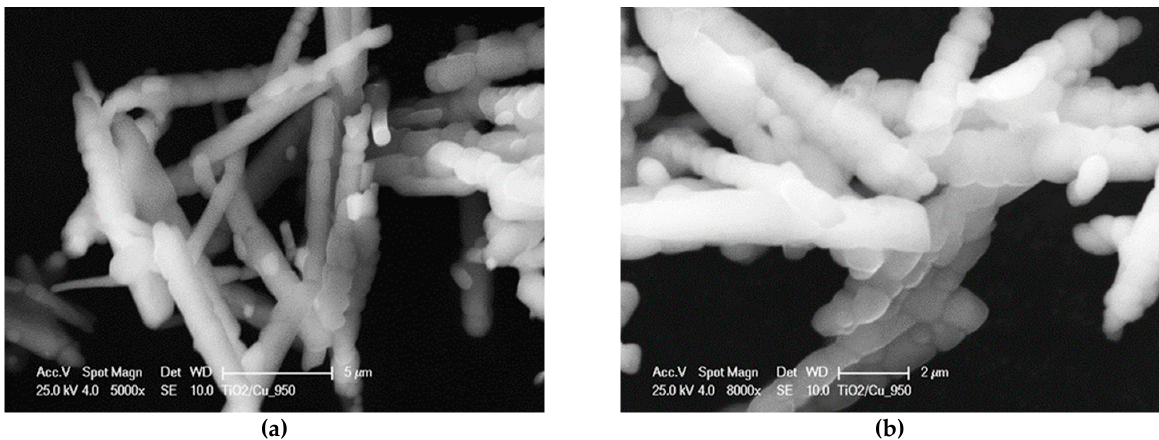
Figure 6. SEM images of the Cu/TiO 2 _950 sample, ( a ) Cu/TiO 2 _950 with 5000× magnification, ( b ) Cu/TiO 2 _950 with 8000× magnification.